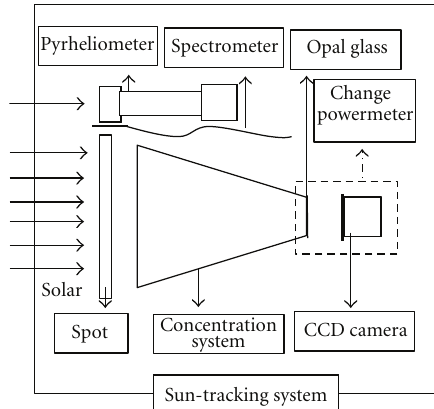
Figure 12: Schematic diagram of outdoor concentration test sys-